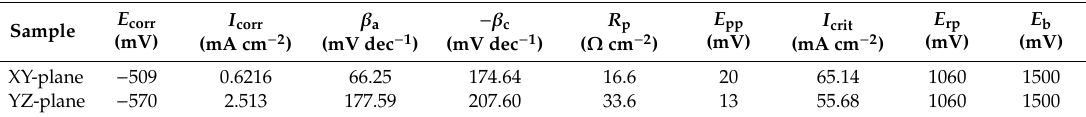
Table 2. Electrochemical parameters extracted and calculated from potentiodynamic polarization curves in 0.1 M H 2 SO 4 solution.